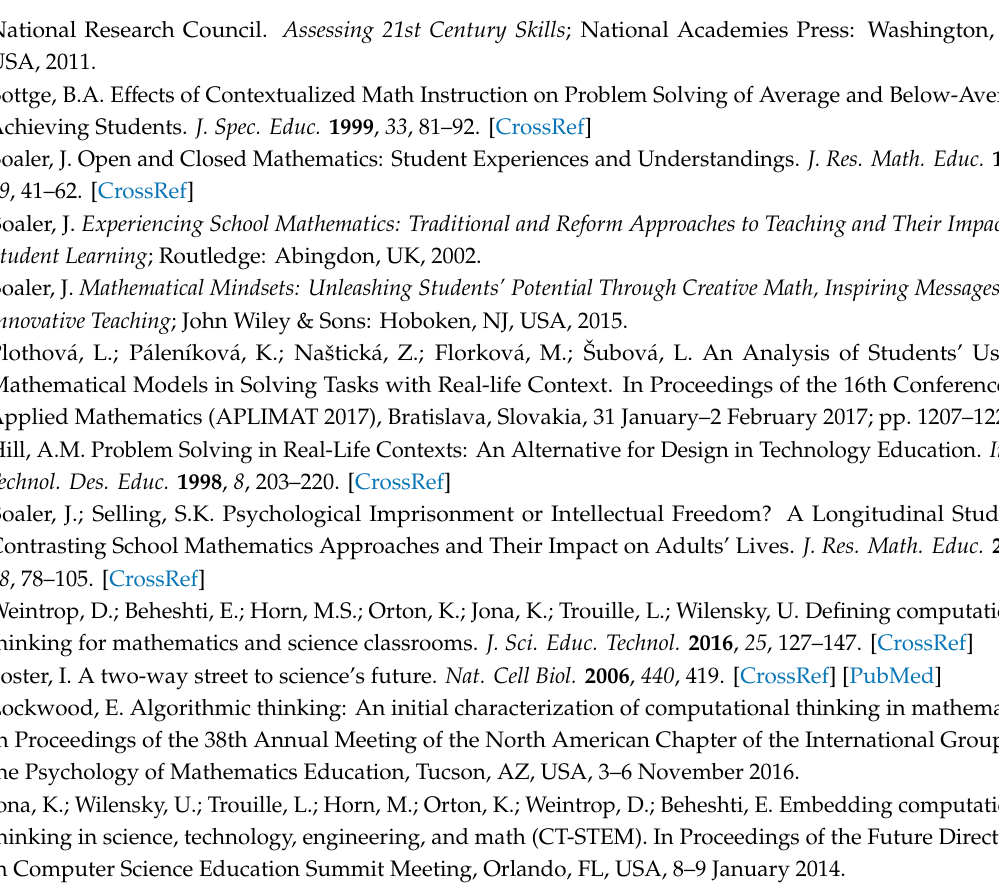
Table S1: Development of the design of the camp in years